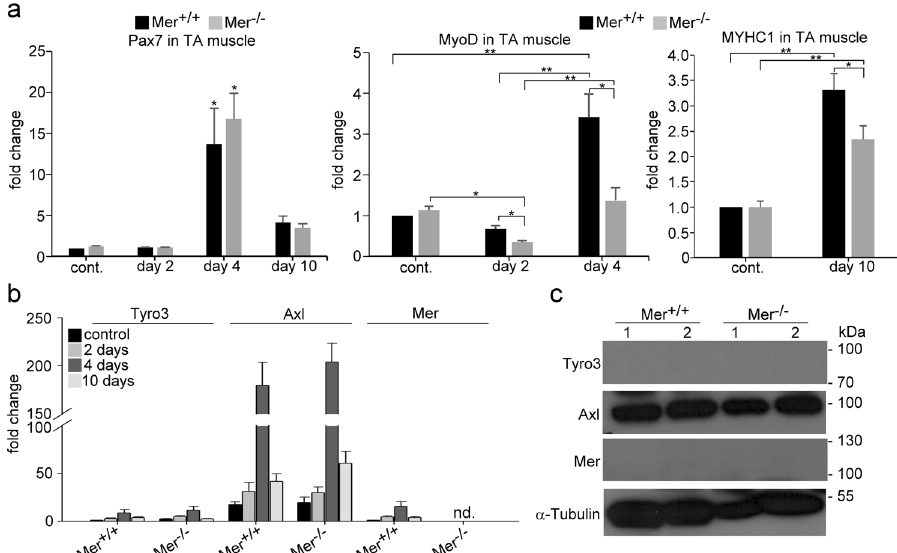
Fig. 2 Expression of TAM kinase family members and myogenic genes in the TA muscle of wild type and Mer null mice. a mRNA expressions of myogenic marker genes Pax7, MyoD and MYHC1 in control and in regenerating wild type and Mer null TA muscles determined by qRT-PCR at day 2, 4, or 10 post-CTX – induced injury. b mRNA expression levels of Mer, Axl and Tyro3 in control and in regenerating wild type and Mer null TA muscles determined by qRT-PCR at day 2, 4, or 10 post-CTX – induced injury. c Protein levels of Mer, Axl, and Tyro3 in the TA muscle of wild-type and Mer null mice determined by Western blot analysis. α Τ ubulin was used as a loading control. Data are expressed as mean ± SEM ( n = 3). Asterisks indicate statistical signi fi cance (* P < 0.05, ** P < 0.01, ANOVA